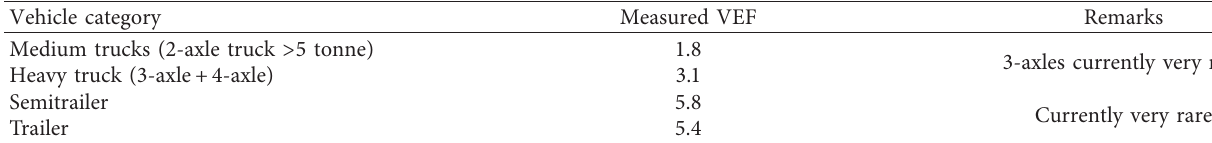
Table 3: Comparison of design and current Vehicle Equivalency Factors (VEF).